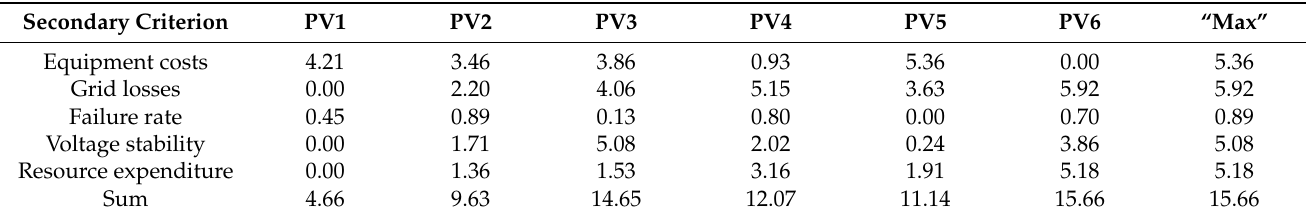
Table 9. Exemplary “baselining” for six planning variants (PV) in the secondary assessment model with a defined Top Score of 6 (without taking weightings into account).